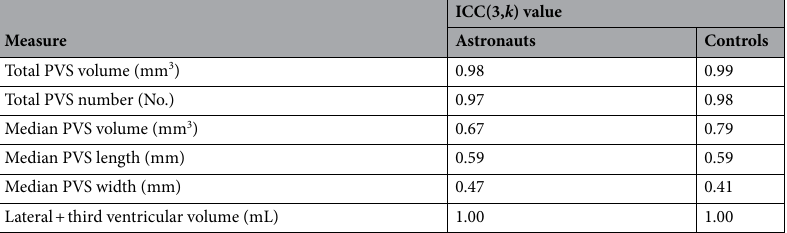
Table 2. Reliability of PVS metrics and ventricular volume. Here we report the ICC(3, k ) values across the two pre-flight scans for the astronauts, and across all four scans for the control group. We planned a priori to exclude from further statistical analyses any metric with an ICC(3, k ) value < 0.50.